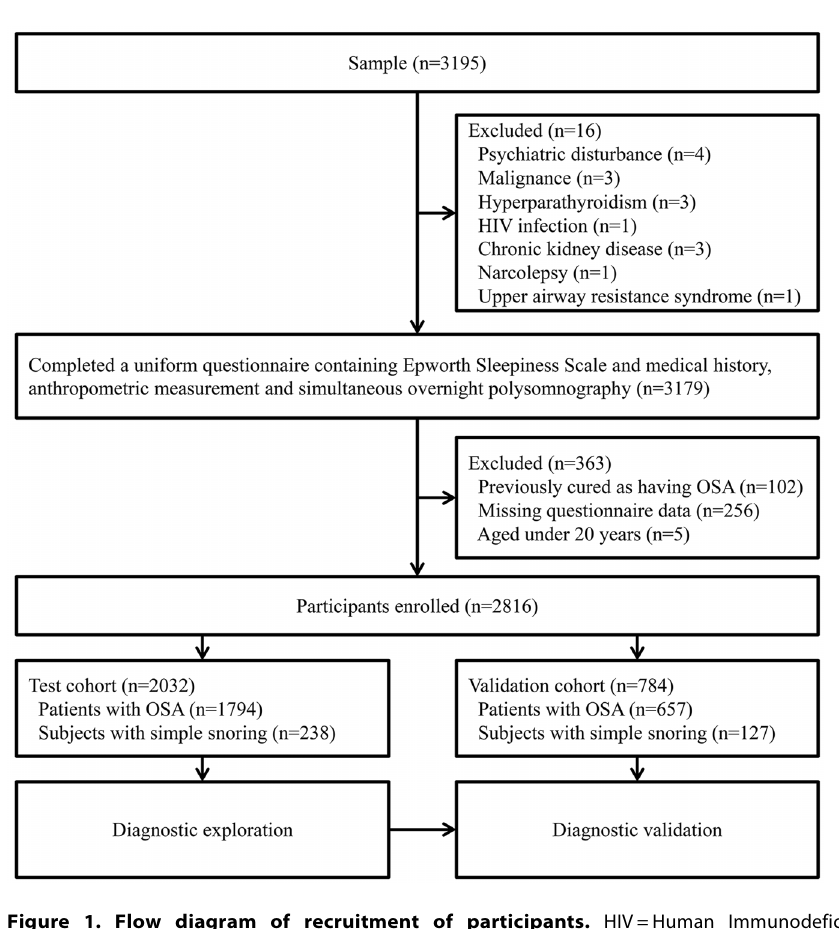
Figure 1. Flow diagram of recruitment of participants. HIV=Human Immunodeficiency Virus; ESS=Epworth Sleepiness Scale; OSA=obstructive sleep apnea.